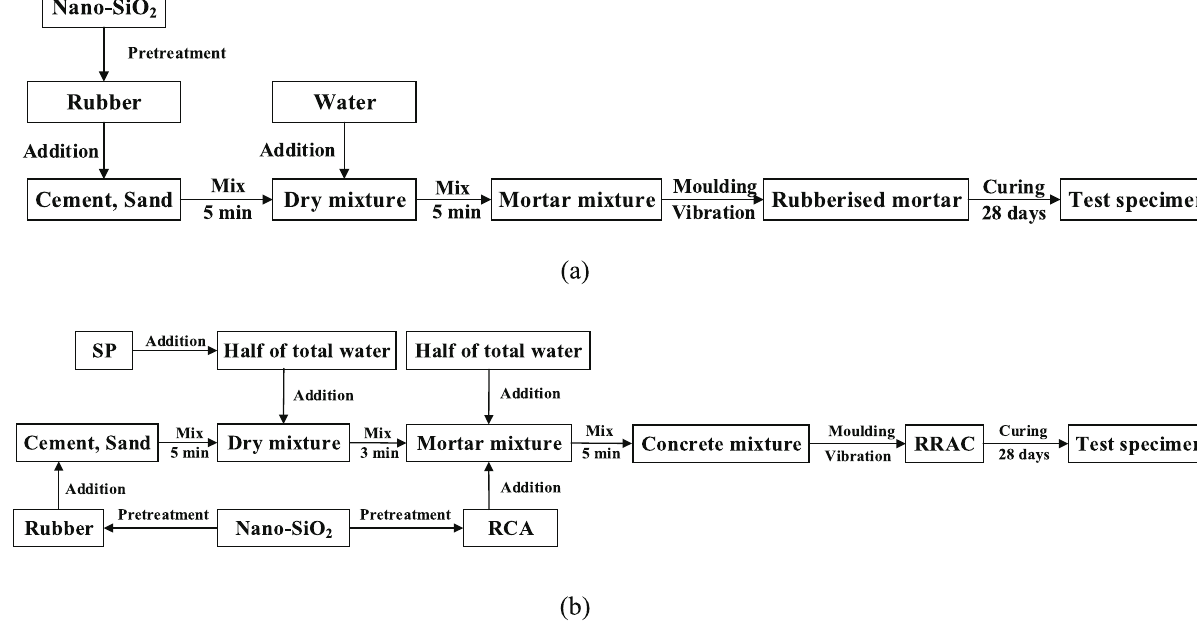
Figure 5: Specimen preparation methods: ( a ) rubberised mortar and ( b )